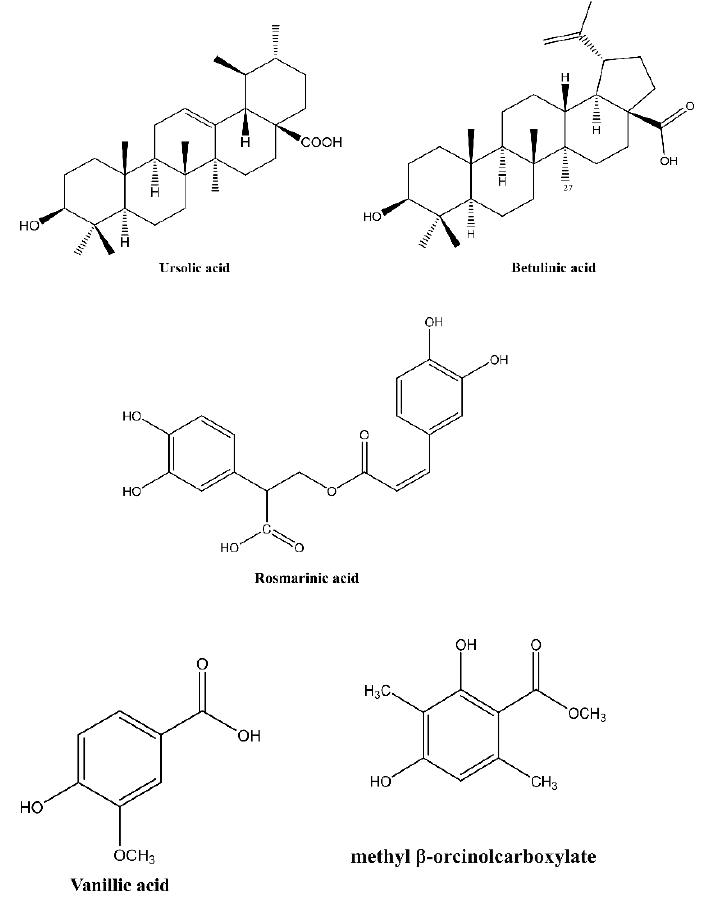
Figure 4. The molecular structure of active compounds.